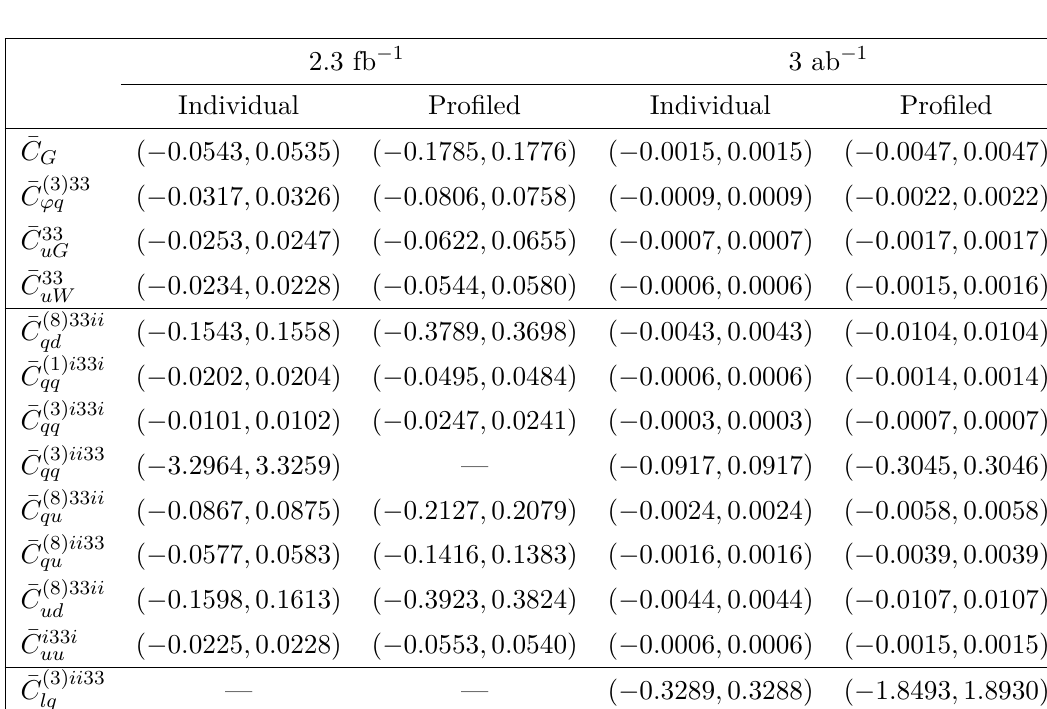
Table 2 . Baseline 2 σ bounds for different